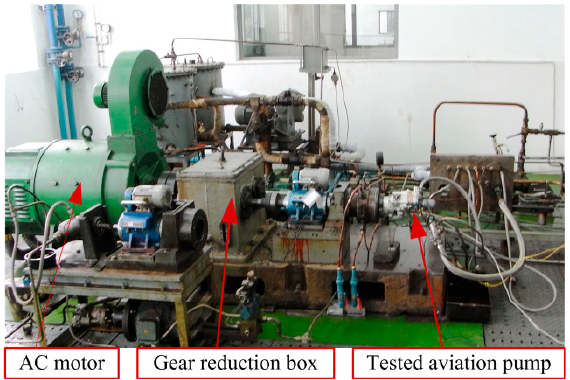
Figure 3. Aviation hydraulic pump test stand.